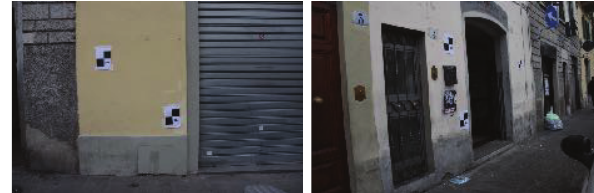
Figure 3. Positioning of Black &White targets for the recognition of detection points.